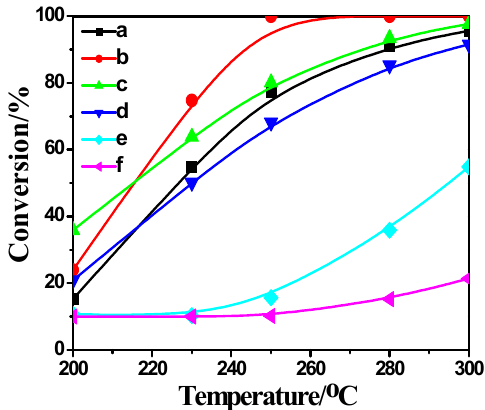
Figure 7. Activity measurement results of N 2 O direct dissociation over Mg x CeyCo 1 − x − y Co 2 O 4 ( x = 0.015, 0.025, 0.05, 0.1, 0.15; y = 0.05) composite spinel metal ‐ oxide catalysts. Reaction conditions: N 2 O:He = 35:65, GHSV = 30,000 h − 1 ; ( a ) Mg 0.015 Ce 0.05 Co 0.935 Co 2 O 4 ; ( b ) Mg 0.025 Ce 0.05 Co 0.925 Co 2 O 4 ; ( c ) Mg 0.05 Ce 0.05 Co 0.9 Co 2 O 4 ; ( d ) Mg 0.1 Ce 0.05 Co 0.85 Co 2 O 4 ; ( e ) Mg 0.15 Ce 0.05 Co 0.8 Co 2 O 4 ; ( f ) Co 3 O 4 .